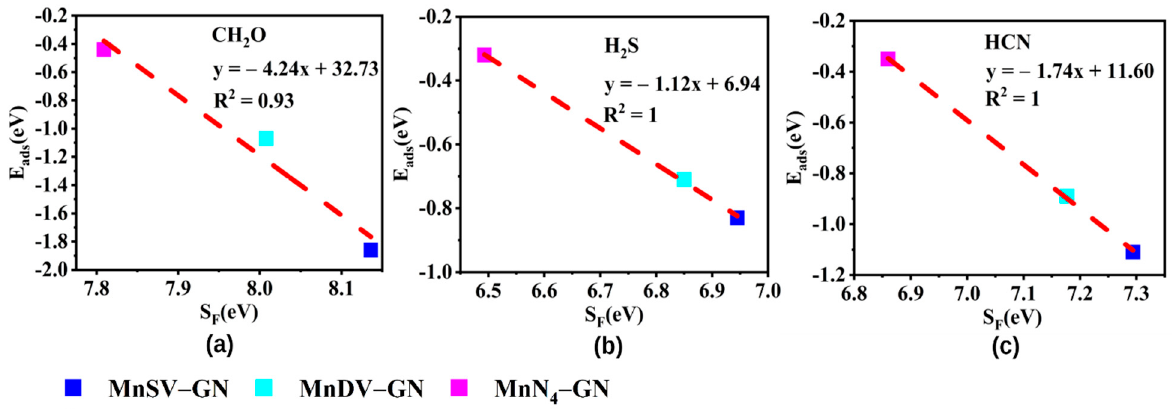
Figure 5. The adsorption energies of ( a ) CH 2 O, ( b ) H 2 S and ( c ) HCN as a function of Fermi soft- ness.